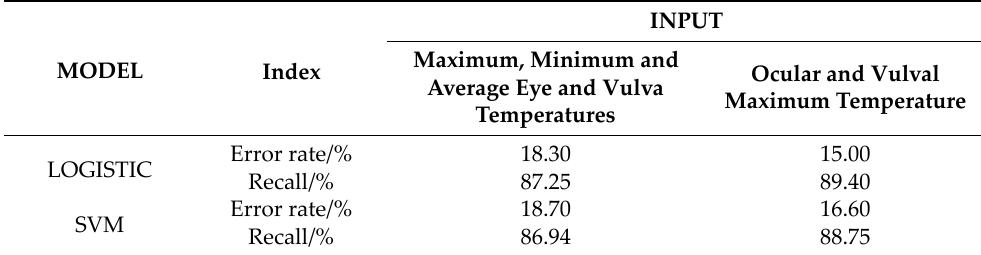
Table 1. Results of recognition test on the estrus behavior of dairy